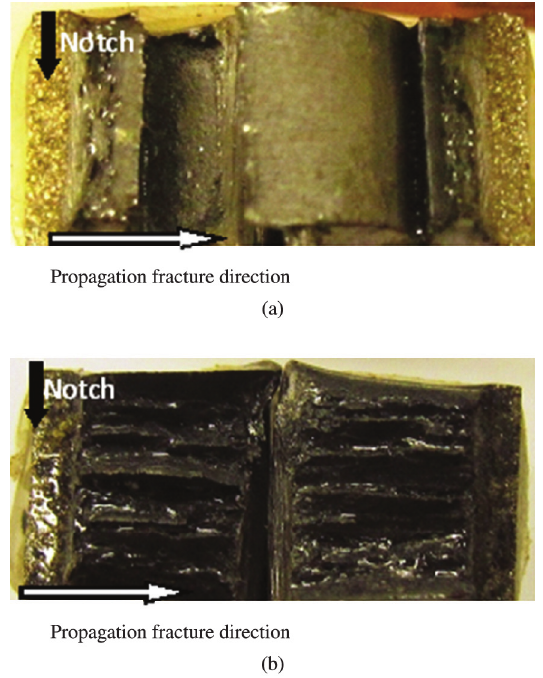
Figure 7. Fractured surface from the impact test showing the delamination phenomenon: a) crack-arrester type delamination; b) crack-divider type delamination